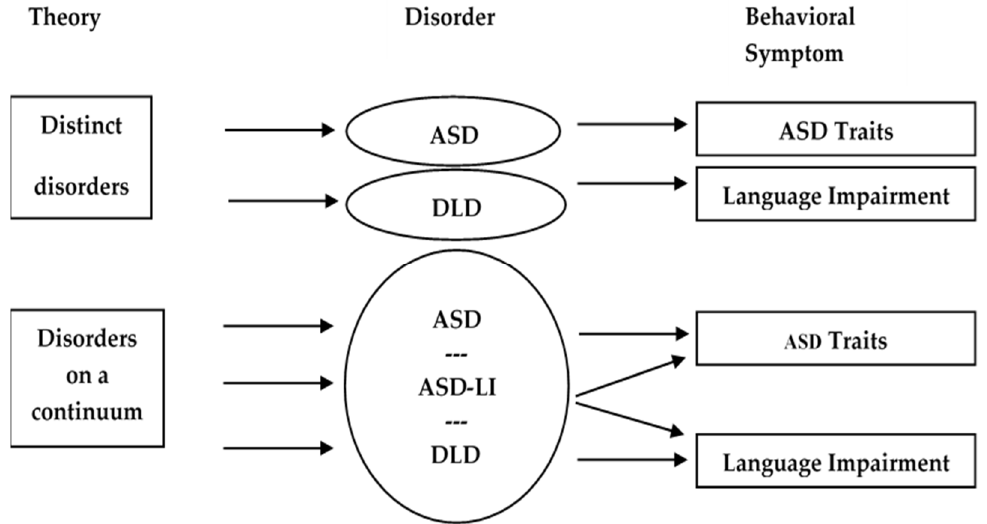
Figure 2. Models of the relationship between DLD and ASD. They depict different theories explaining the relation between ASD and DLD.